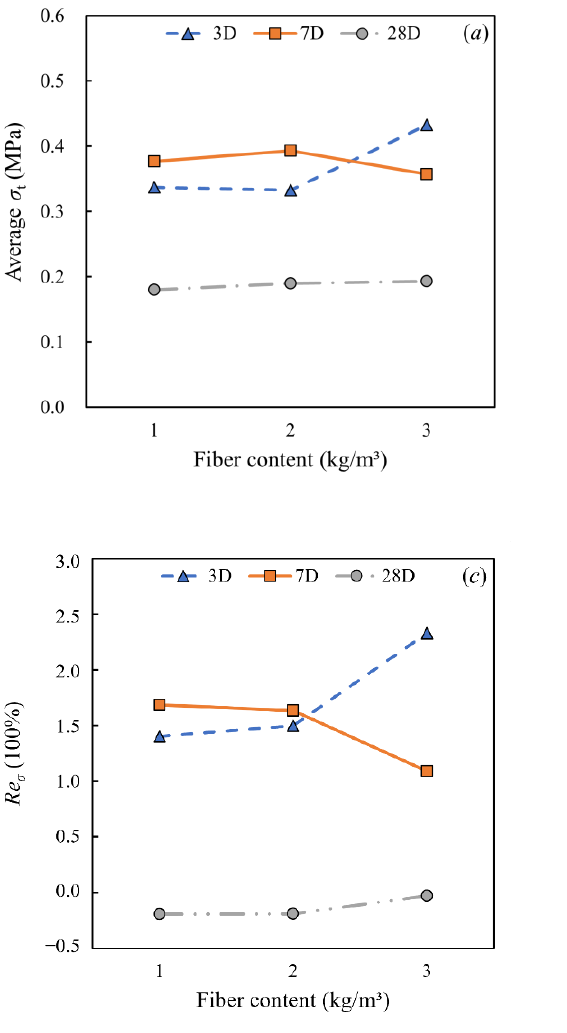
Figure 8. The influence of RS fiber on ITS and Re σ . ( a ) Average σ t at different RS fiber contents; ( b ) average σ t at different RS fiber lengths; ( c ) average Re σ at different RS fiber contents; ( d ) average Re σ at different RS fiber lengths.